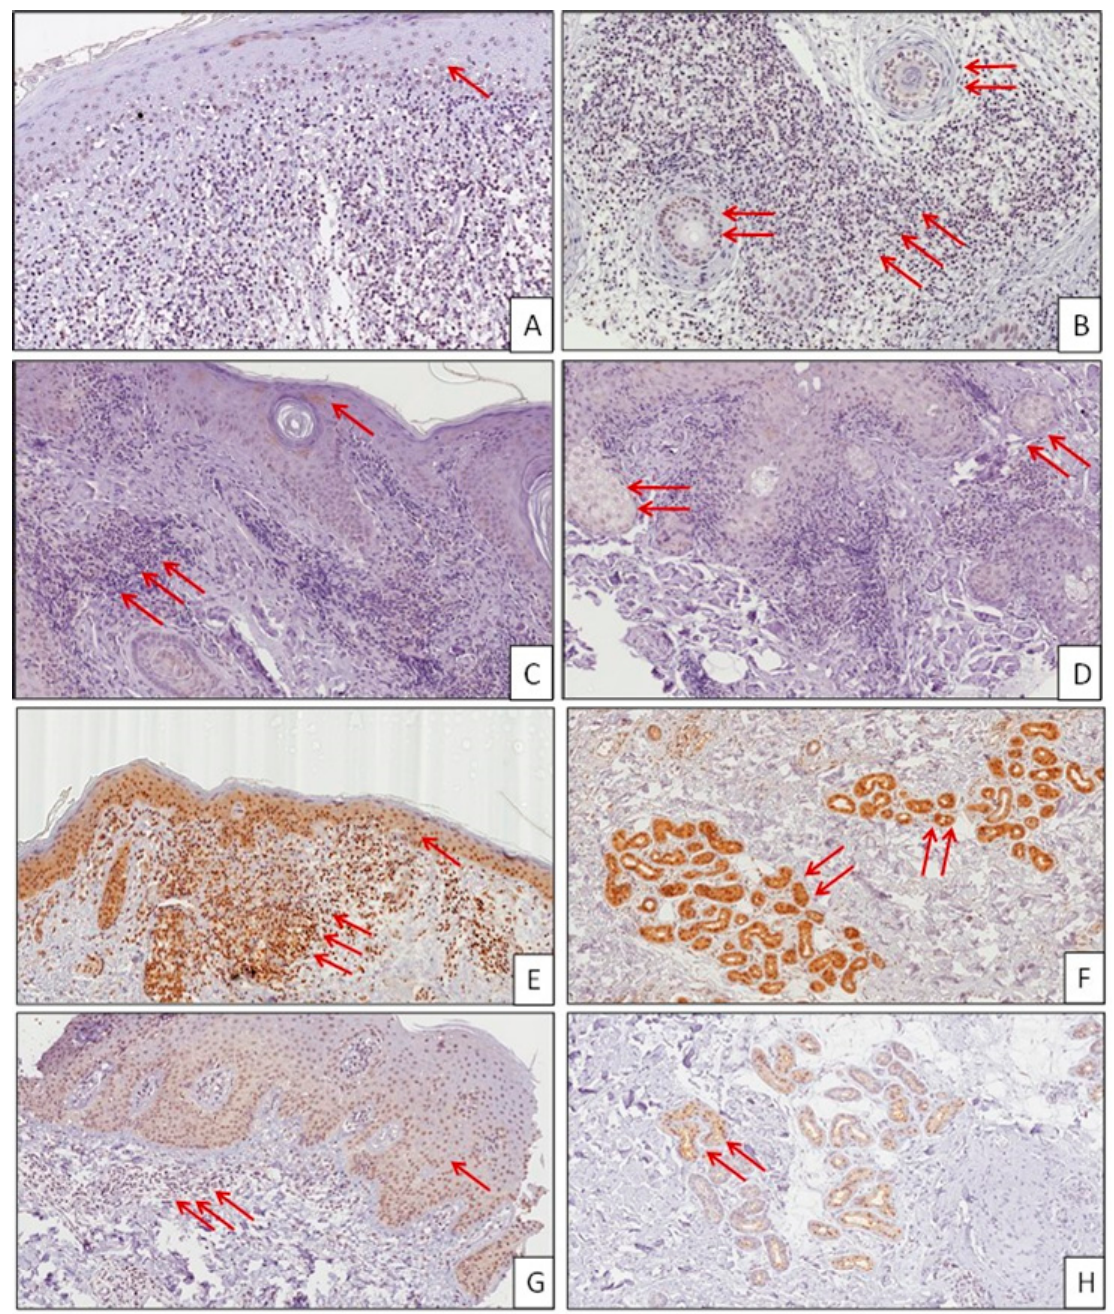
Figure 2. Immunohistochemistry analysis of MIF expression in DLE skin biopsies. Thirty-seven patients with DLE were recruited for this study. Biopsies were performed after a six-month wash-out period from topical treatments. Hematoxylin and eosin staining was used for histopathological evaluation. Representative microphotographs are shown. ( A – D ) In the presence of a high inflammatory score (2+; 3+), MIF low expression (0; 1+) was observed in the epidermis (one arrow), appendages (two arrows), and inflammatory infiltrate (three arrows). (( A , B ): patient no. 1; ( C , D ): patient no. 2). ( E – H ) In the presence of a low inflammatory score (0; 1+), MIF high expression (2+; 3+) was observed in the epidermis (one arrow), appendages (two arrows), and inflammatory infiltrate (three arrows). Immunohistochemistry positive staining was defined as the presence of brown chromogen detection within the cytoplasm. ( E , F ): patient no. 3; ( G , H ): patient no.